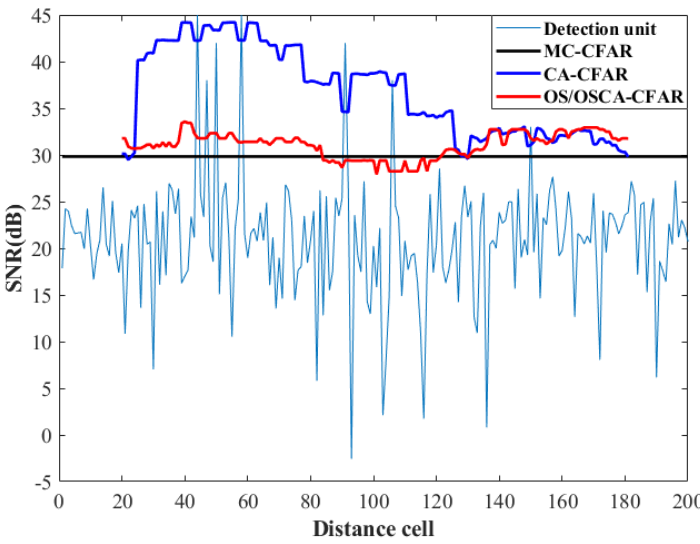
Figure 14. Multi-target detection simulation of MC-CFAR